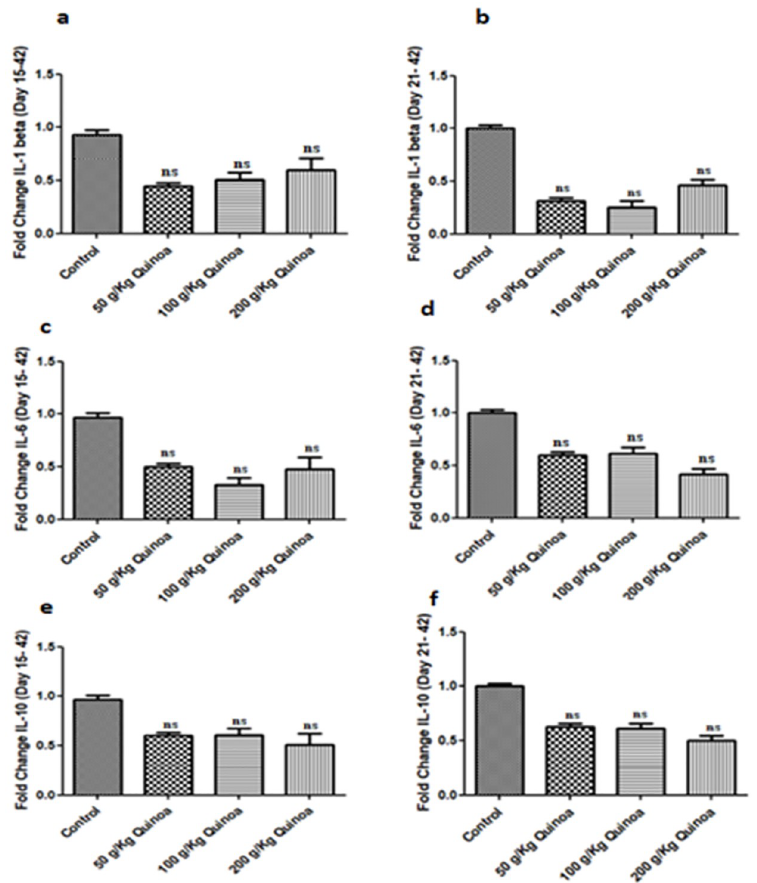
Fig 7. Graph showing the quantitative real time-PCR (qRT-PCR) analysis of liver from different quinoa enriched diet given chicken groups fed from days 15 to 42 post-birth (growth phase) and days 21 to 42 post-birth (finisher phase). ( a ). IL-1 beta (Growth phase) ( b ). IL-1 beta (Finisher phase) ( c ). IL-6(Growth phase) ( d ). IL-6 (Finisher phase) ( e ). IL-10(Growth phase) ( f ). IL-10 (Finisher phase). Expression of IL-1 beta, IL-6, and IL-10 normalized with GAPDH. The chickens were given 50 g/Kg, 100 g/Kg, and 200 g/Kg of quinoa. All data are expressed as means ± standard deviation (SD) from measurements on 15 chickens. � p � 0.05 in all Quinoa supplemented diet fed groups versus the commercially available diet without Quinoa fed control group. Note : ns means not